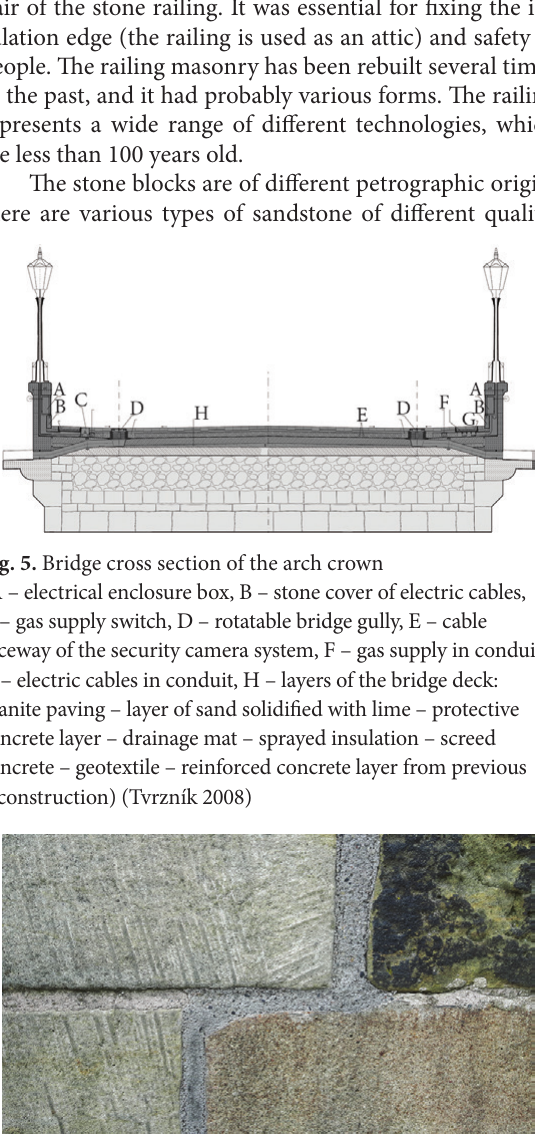
Fig. 6. Dilatation joint filled with polyurethane sealer and surface